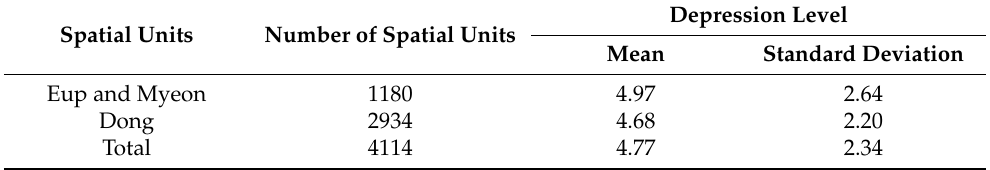
Table 3. Basic statistics of the Eup, Myeon, and Dongs.